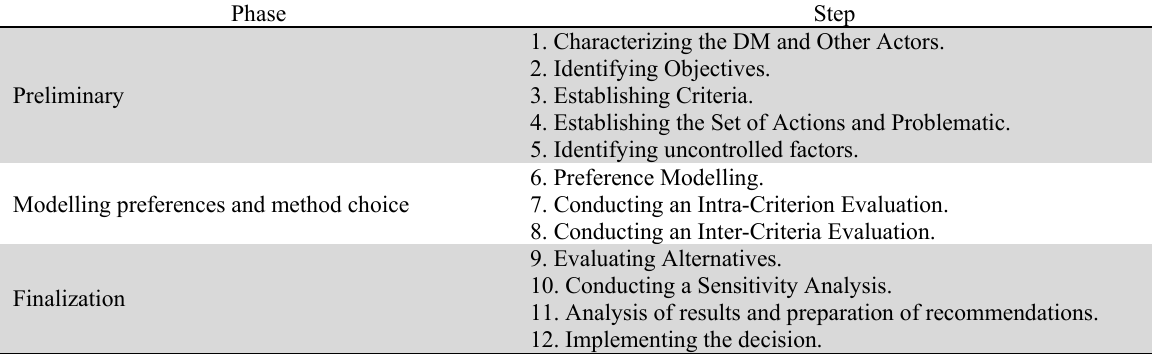
Framework proposed by De Almeida